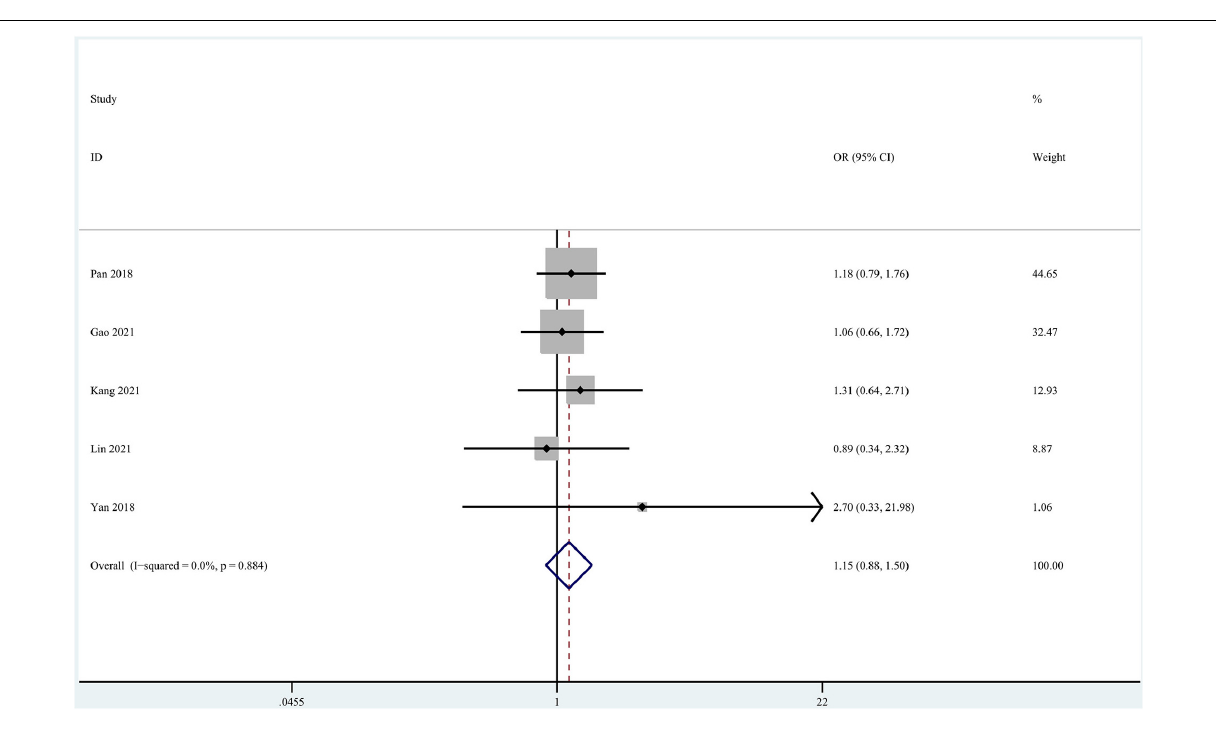
starts from PET data generation based on MRI data to AD diagnosis with the generated PET data, leading to 0.85 accuracy and 0.84 precision and recall in the task of AD vs. CN